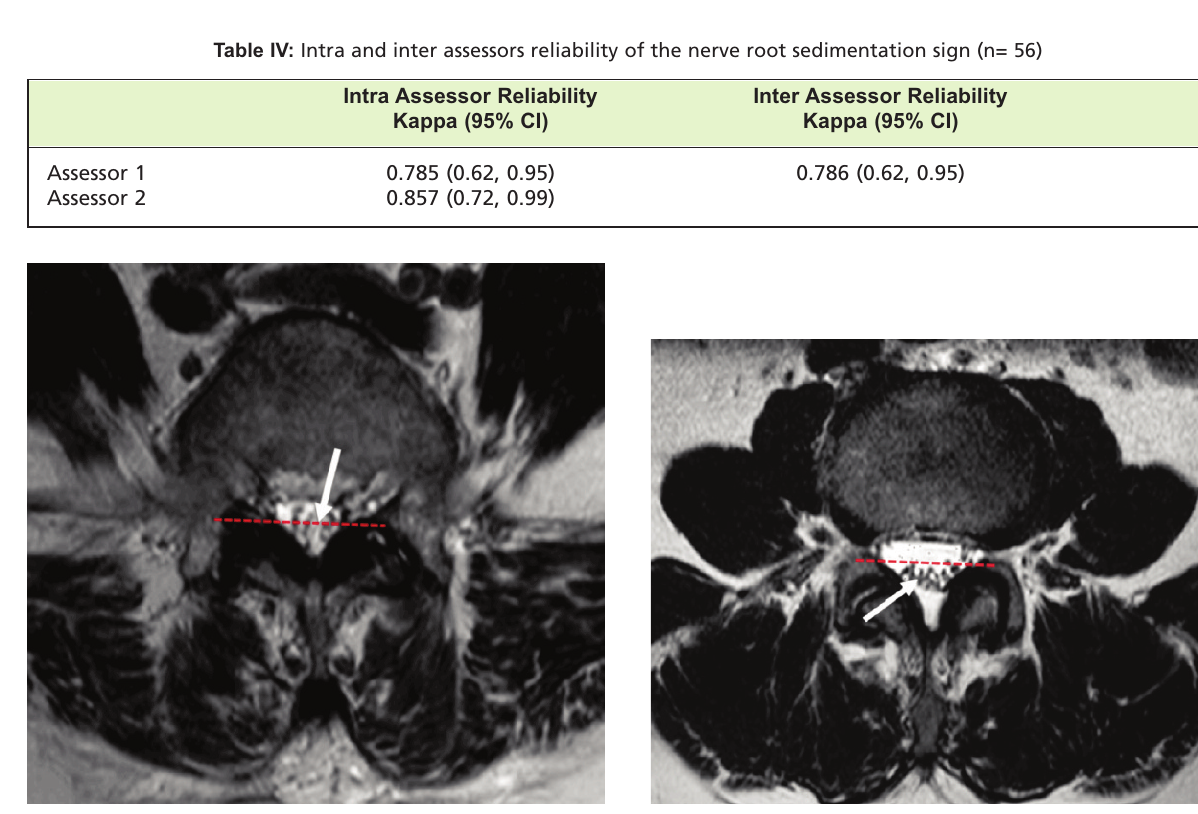
MRI T2 image of a patient with positive nerve root Fig. 1: sedimentation sign. A positive sign was defined when most of the nerve roots (arrow) in the dura sac was located in the area above an imaginary line (dotted line) dividing the spinal canal into two halves.